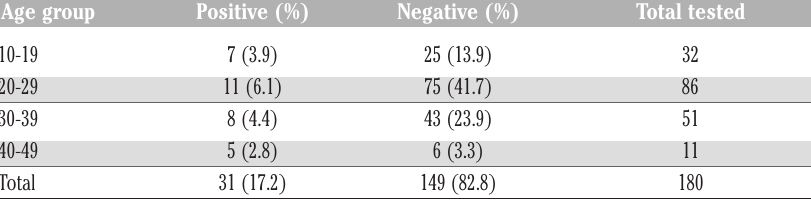
Table 2. Distribution based on age group hepatitis B surface antigen status.